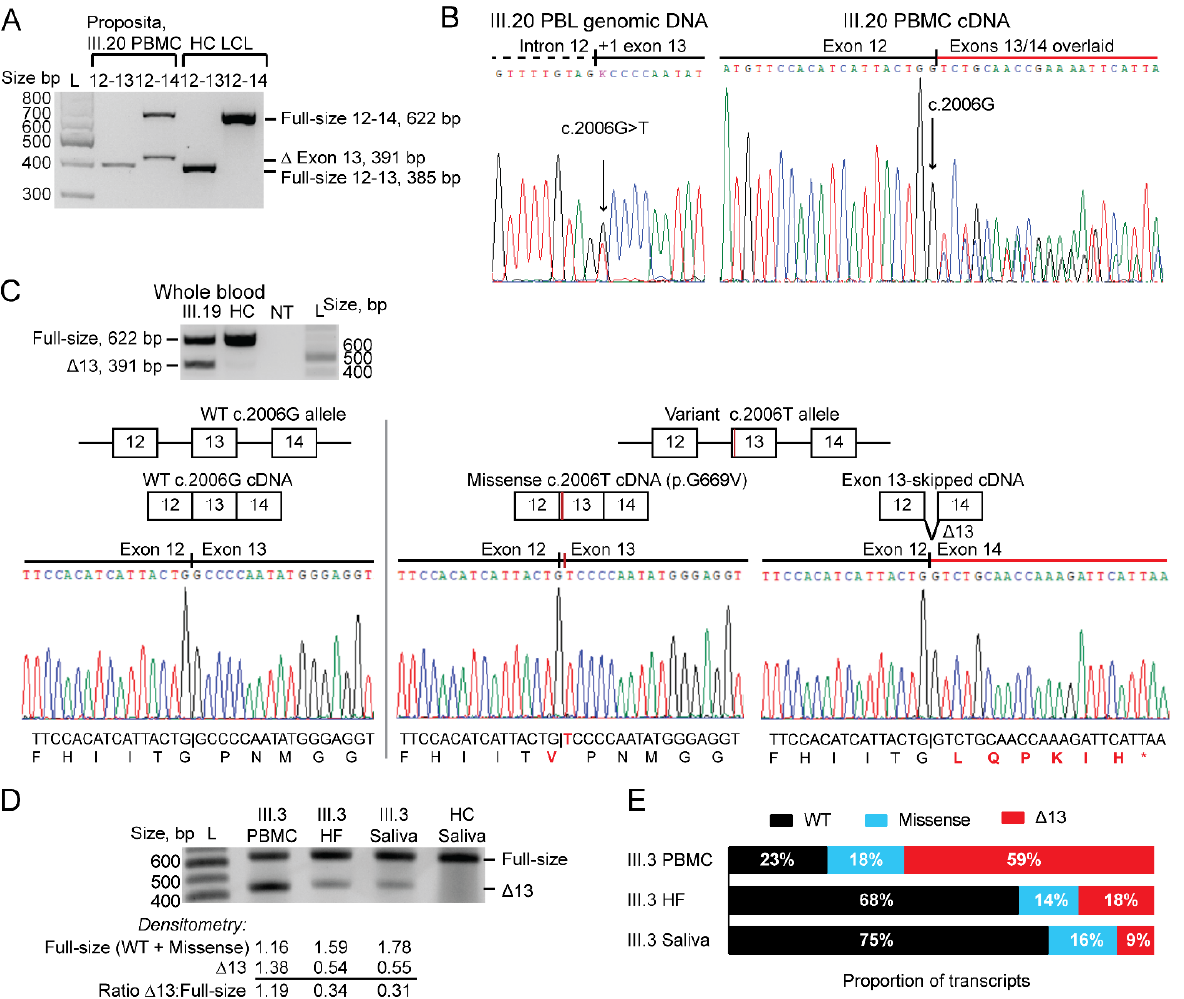
Figure 4. MSH2 c.2006G>T is associated with both exon 13-skipped and full-sized missense G>T transcripts at different proportions within different tissue types. ( A ) Electrophoretic separation of reverse-transcriptase (RT) PCR products of mRNAs from peripheral blood mononuclear cells (PBMC) from the proposita (carrier of the MSH2 c.2006G>T variant) and cultured lymphoblastoid cells (LCL) from a healthy control (confirmed non-carrier). RT-PCRs were conducted using the same forward primers within MSH2 exon 12 and a reverse primer within either exon 13 (385 bp amplicon) or exon 14 (622 bp full-sized amplicon; 391 bp exon 13-skipped amplicon). ( B ) Sequence electropherograms across the c.2006G>T site (black arrows) within the proposita’s genomic DNA (left) and PBMC cDNAs amplified between exons 12–14 (right). The cDNA electropherogram becomes asynchronous from c.2007 due to exon-13 skipping. Only the wild-type G allele was detected at c.2006; the missense T allele was not observed above background noise levels. ( C ) Electrophoretic separation of whole blood MSH2 exon 12–14 RT-PCR products from the proposita’s sister, III.19 (c.2006G>T carrier) and the same healthy control as in A. Beneath, sequence electropherograms of individual transcripts separated by cloning RT-PCR product, showing the wild-type transcript from the c.2006G allele (left), and mutant transcripts from the c.2006T allele, including a full-length missense transcript (middle) and exon 13-skipped transcript (right). The predicted amino acid sequences for each transcript are shown below the respective electropherogram, with altered amino acid sequences shown in red font. The missense c.2006G>T transcript results in a glycine to valine substitution (p.Gly699Val). The frameshift generated by the exon 13-skipped transcript results in the introduction of a novel sequence of six amino acids followed by a premature stop codon (*). ( D ) Gel electrophoresis and densitometry to quantify relative levels of exon 13-skipped transcripts from full-length (wild-type and missense) transcripts in different tissues from the same carrier, III.3. ( E ) Histogram showing the proportions of the exon 13-skipped, missense c.2006T, and wild-type tran- script identified among the cloned RT-PCR (cDNA) products, confirmingvariable levels of the exon 13—skipped versus missense c.2006T transcripts across different tissues from the same carrier, III.3,